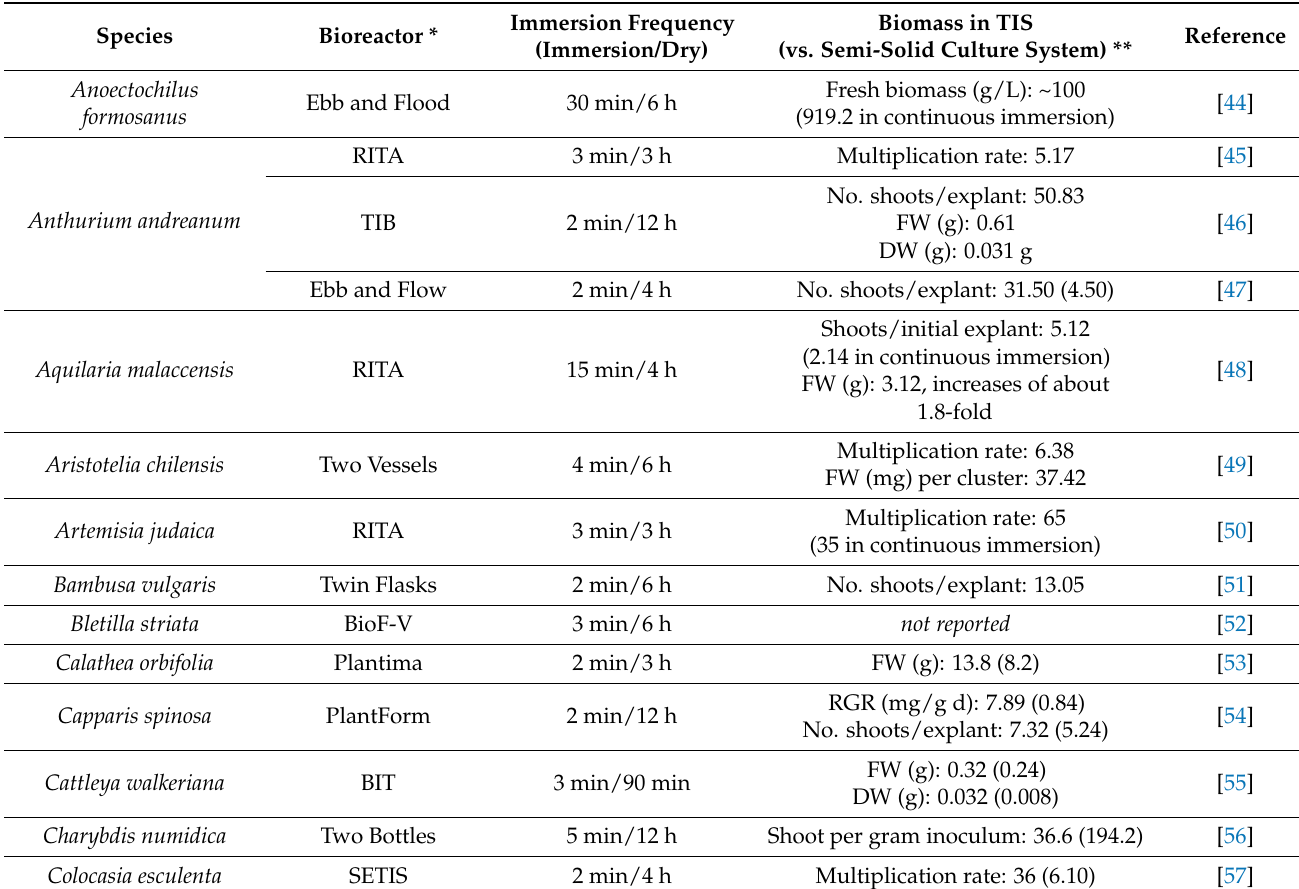
Table 1. Biomass production in medicinal plants cultured in TIS with different bioreactors and immersion times. Best results are reported for each species (terminology and values are the same as mentioned by the